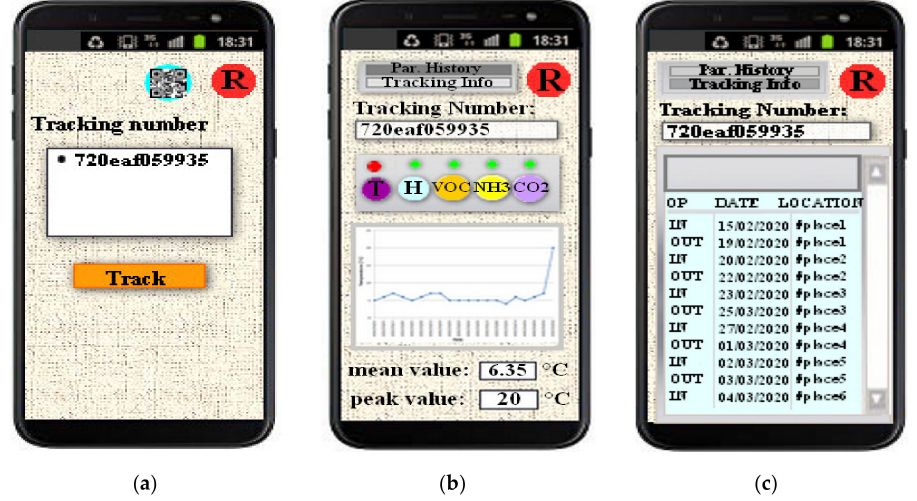
Figure 21. Application screenshots of the tracking and traceability system based on BLE tags. ( a ) logged user (R) inserts the container universally unique identifier (UUID); ( b ) “Par. History” section with shown the history of acquired parameters; ( c ) “Tracking Info” section where the customer checks the tracking information related to the entered